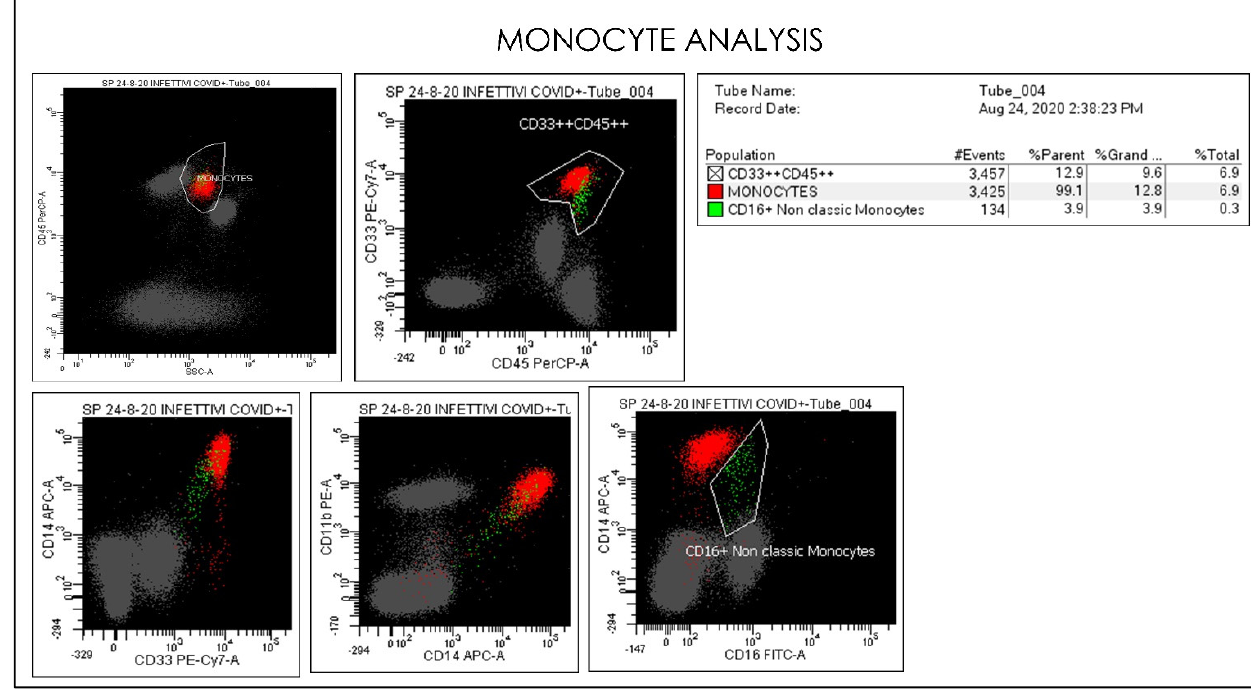
Figure 13. Flow cytometry gate-strategy show activated monocytes subsets and CD16 non-classic monocytes. In the conventional gating strategy is represented classical monocytes and non-classical monocyte populations based on CD14+CD16+ monocytes expression.